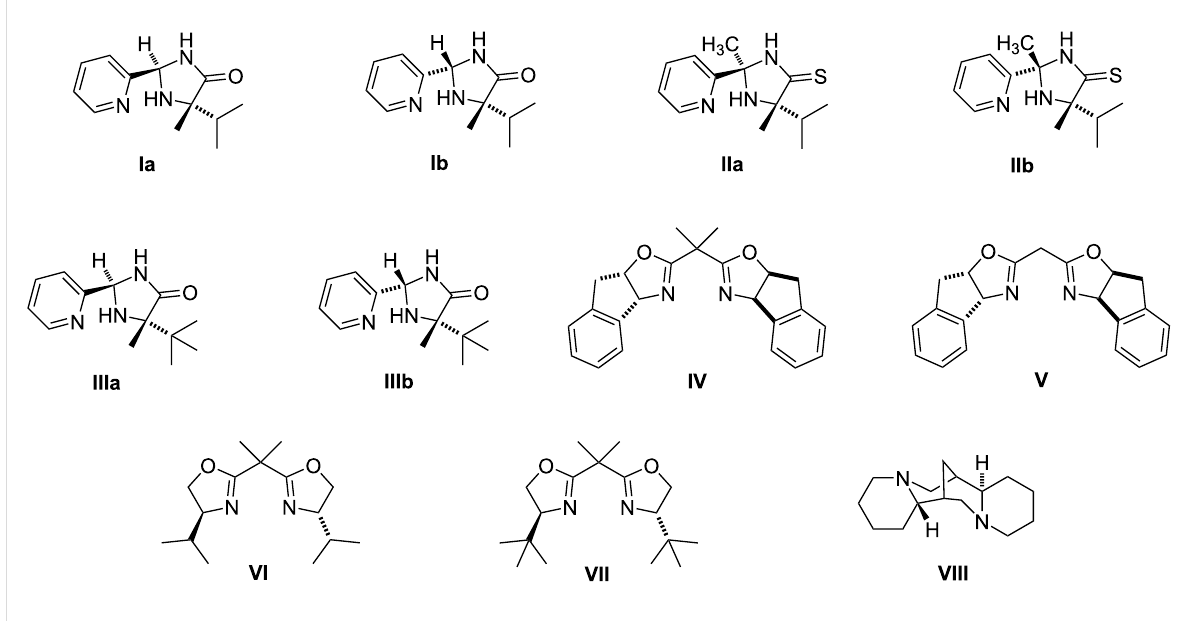
Figure 2: Overview of the chiral ligands that were used for the study of the asymmetric Henry